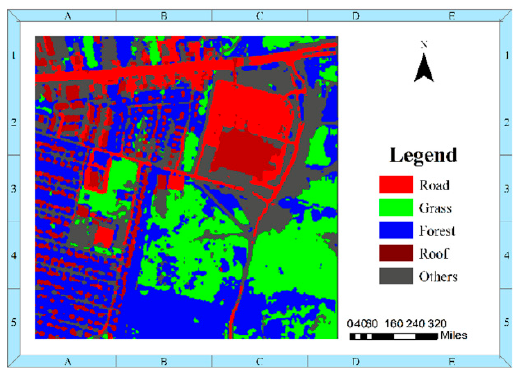
Figure 4. Classification results of the studied